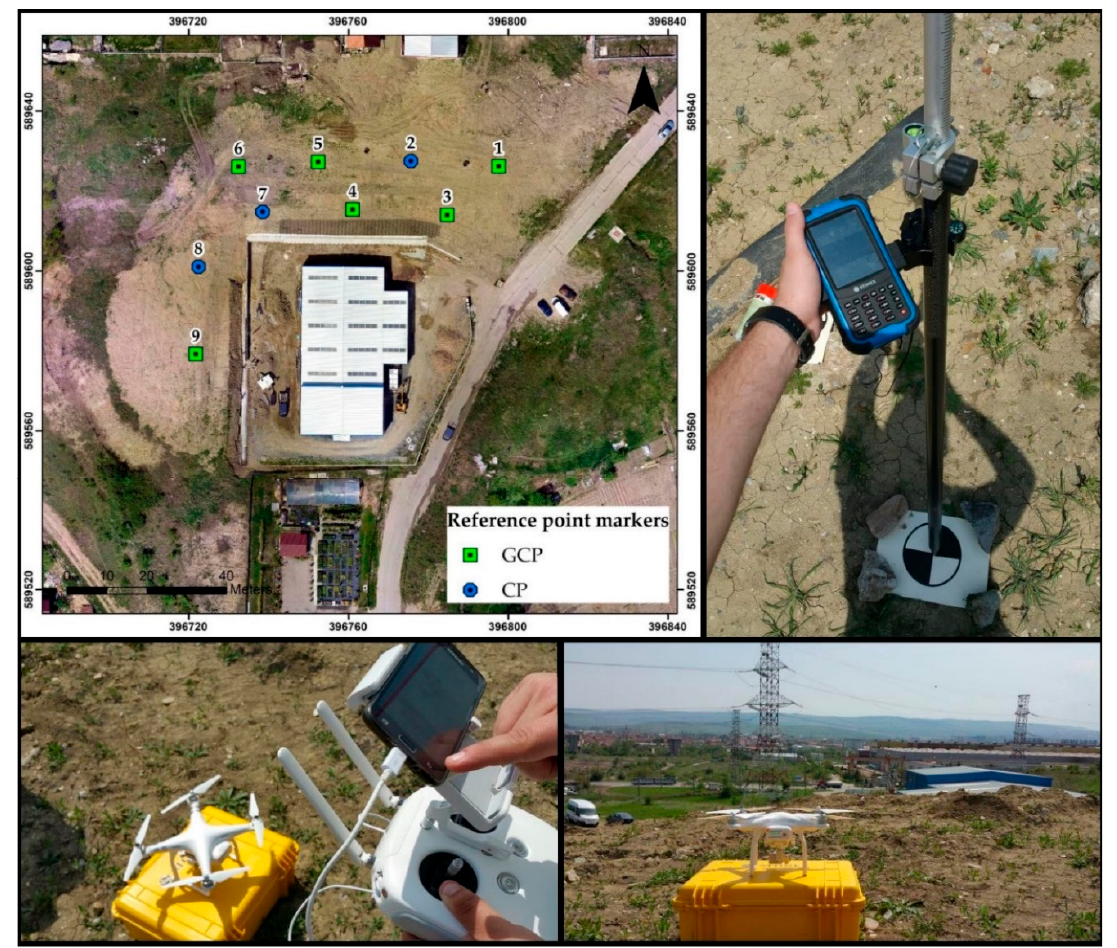
Figure 9. Obtained orthophoto with GCPs and CPs positioning and the instrumentation used.